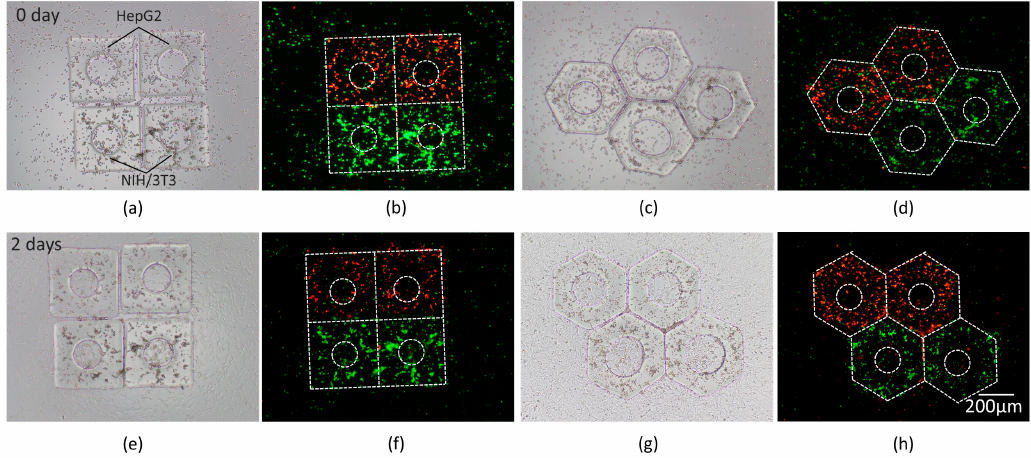
Figure 11. Co-culture of HepG2 and NIH/3T3 cells in micromodules; ( a , c ) Bright field images. ( b , d ) Fluorescence images. ( e – h ) Images after 2-day culture. HepG2 cells were labeled by a red fluorescent reagent and NIH/3T3 cells were labeled by a green fluorescent reagent. The contours of micromodules are marked by white dash lines.